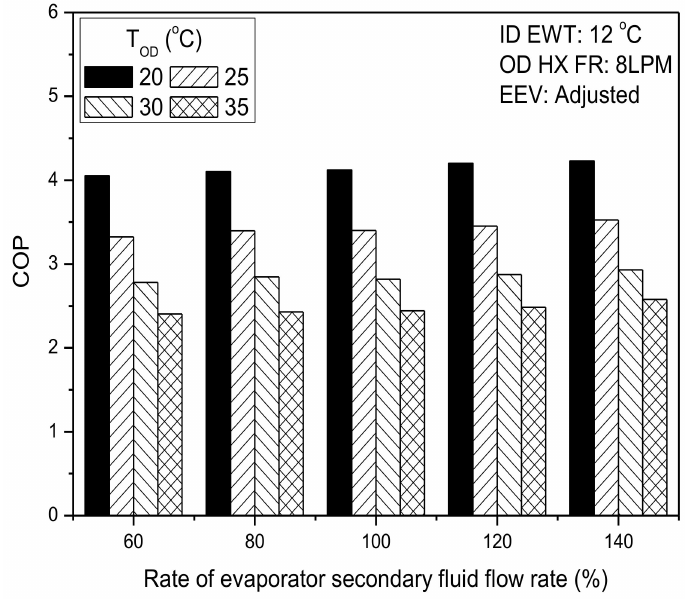
Figure 4. COP variation with evaporator flow rate and T OD